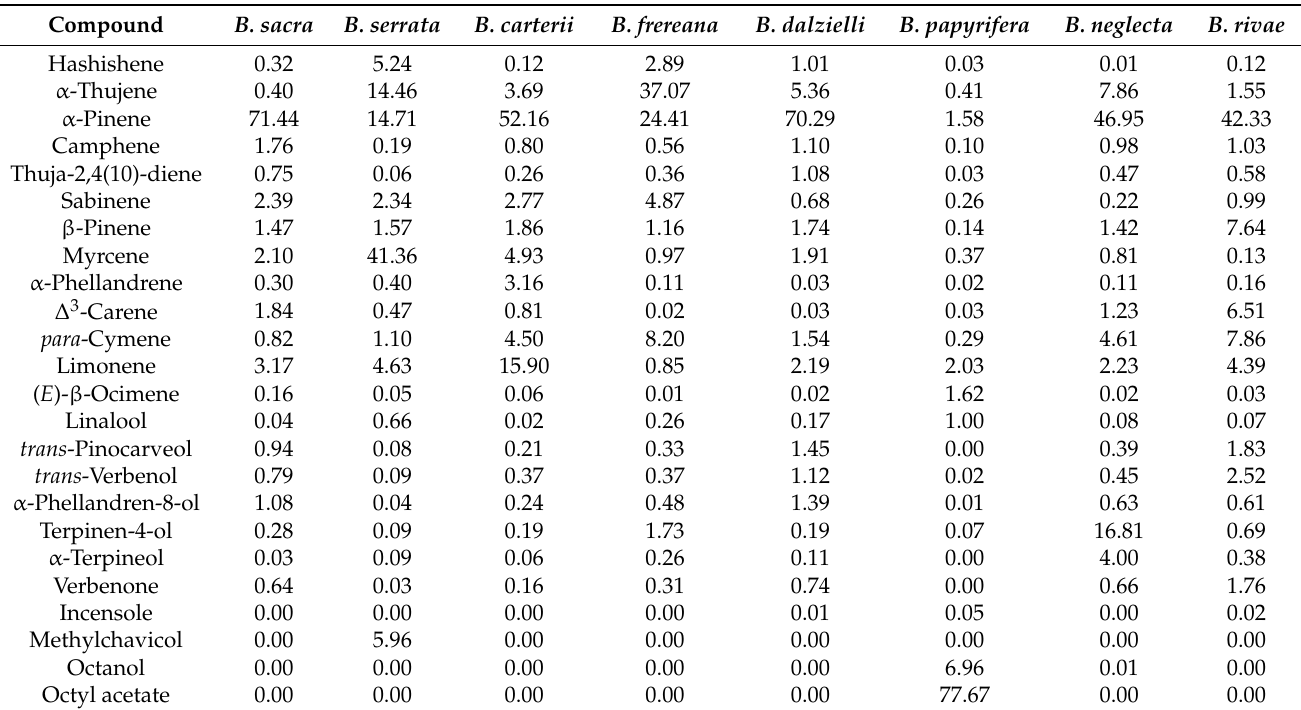
Table 4. Chemical composition of Boswellia spp. oleogum resin essential oils. Relative quantification by gas chromatography and flame ionization detection (GC-FID) using internal normalization, areas in uncorrected %. List of main components (area >1%), plus the potential psychoactive diterpenoid